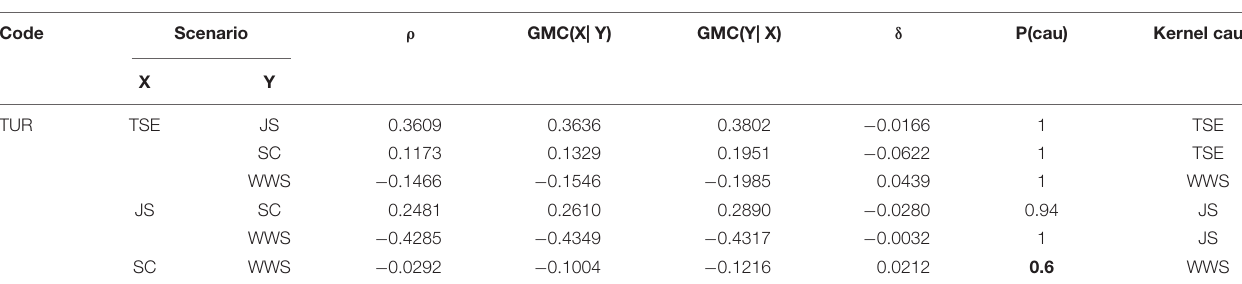
TABLE 10 | Summary of GMC for Turkey.